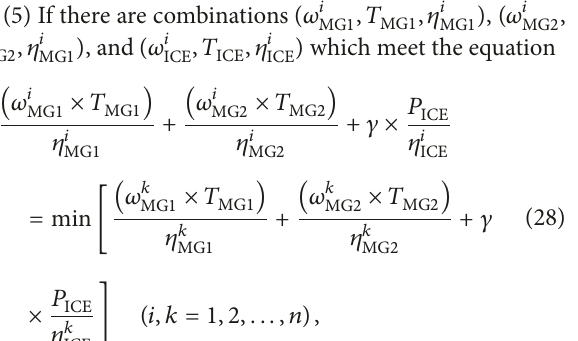
Figure 6: Variables changing curves in upshift speed regulation